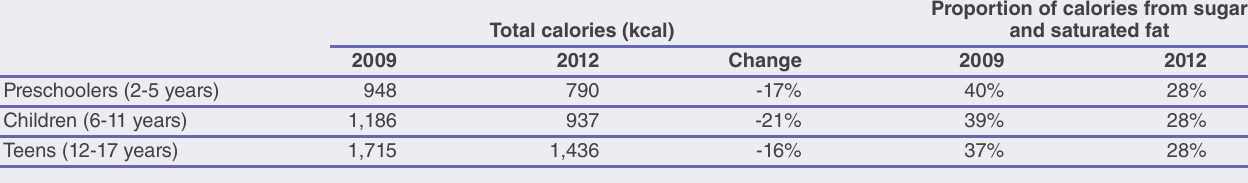
Proportion of calories from sugar